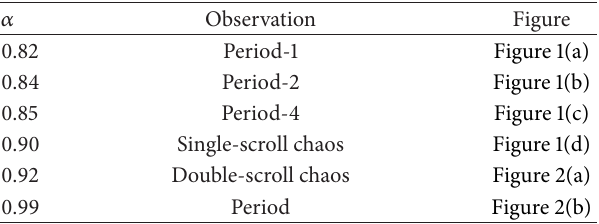
Table 1: Dynamics of system (13) with 𝑏 22 = 2.0 , 𝑐 22 = −1.5 , and different 𝛼 .